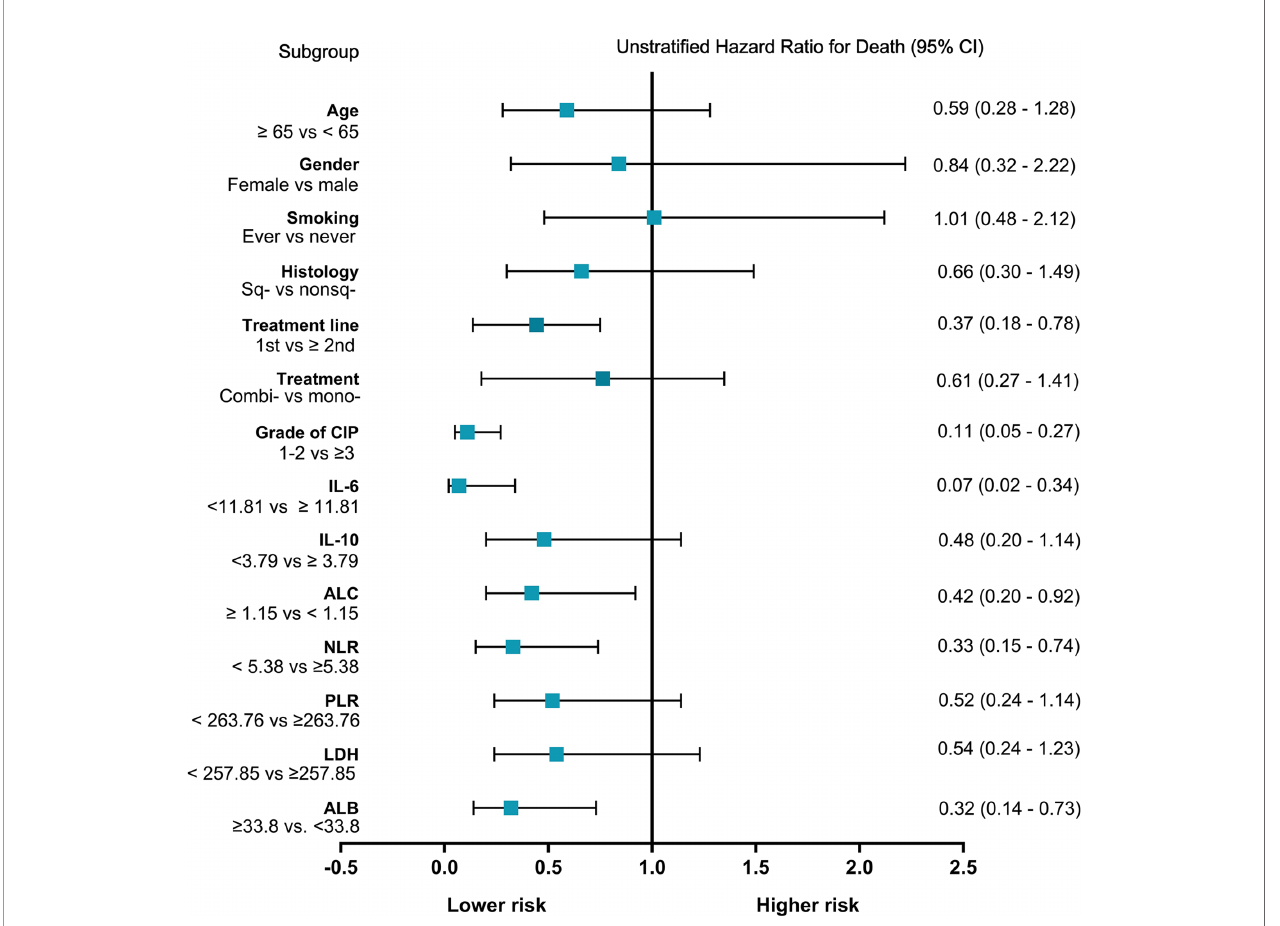
FIGURE 3 | Forest plot of subgroup analyses of prognostic factors for overall survival of checkpoint inhibitor pneumonitis (CIP). Sq-, squamous; nonsq-, nonsquamous; combi-, combination; mono-, monotherapy; IL-6, interleukin-6; IL-10, interleukin-10; the units for IL-6 and IL-10 are both pg/ml; ALC, absolute lymphocyte count, the unit for ALC is K/ m l; NLR, neutrophil to lymphocyte ratio; PLR, platelet-to-lymphocyte ratio; LDH, lactate dehydrogenase, the unit for LDH is U/L; ALB, albumin, the unit for ALB is g/L; CI, con fi dence interval.